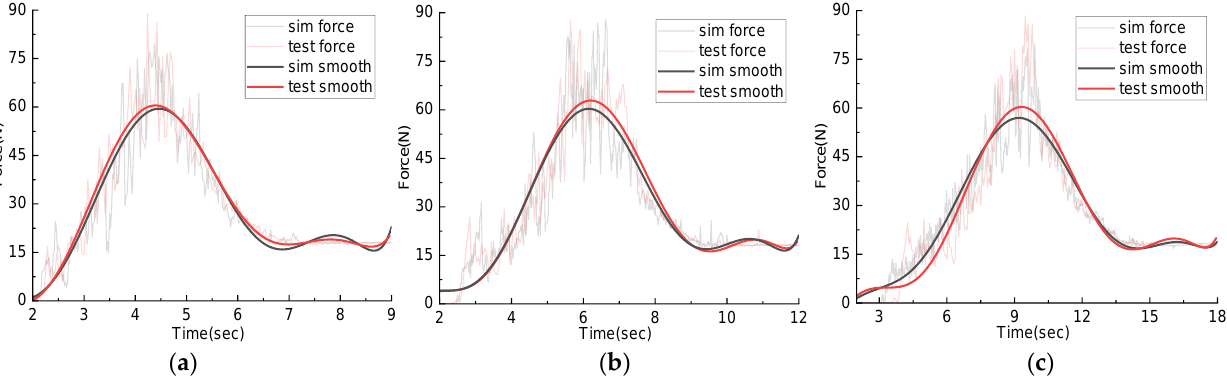
Figure 16. Comparison between simulation data and experimental data of excavation resistance under different speed combinations: ( a ) High-speed excavation; ( b ) Medium-speed mining; ( c ) Low-speed excavation.